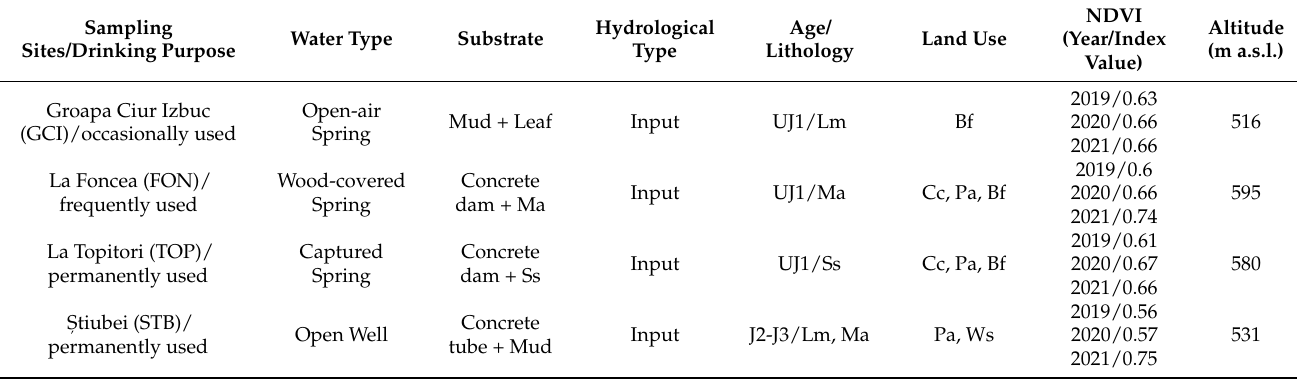
Table 1. Description of the monitored springs. Input/output/independent output refers to the stud- ied water sources within the hydrological context of the karst system of the Runcuri Plateau (KSRP). Age of rocks within which monitored springs developed: UJ1 = Upper part of the Lower Jurassic; J2–J3 = Limit of Middle and Upper Jurassic; J1, J2, J3 = Upper, Middle, and Lower Jurassic; C1 = Lower Cretaceous. Lithology: Lm = Limestones; Ma = Marls; Ss = Sandstones. Land use: Bf = Broad-leaved forest; Cc = Complex cultivation pattern; Pa = Land mainly used for agriculture; Ps = Pastures; Ws = Transitional woodland shrub; Rf = Discontinuous rural fabric. NDVI = Normalized difference vegetation